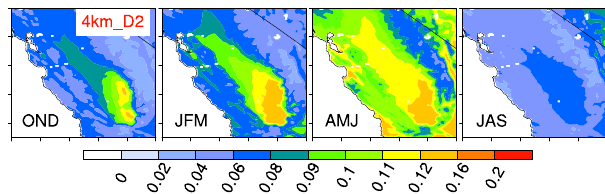
Figure 11. Spatial distribution of seasonal mean 550nm AOD from the 4km_D2 run in